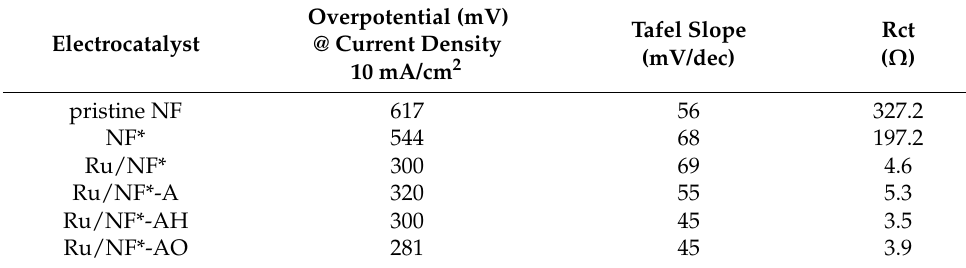
Table 3. Corresponding parameters of electrocatalysts in 0.1 M PBS as calculated from Figure 6.